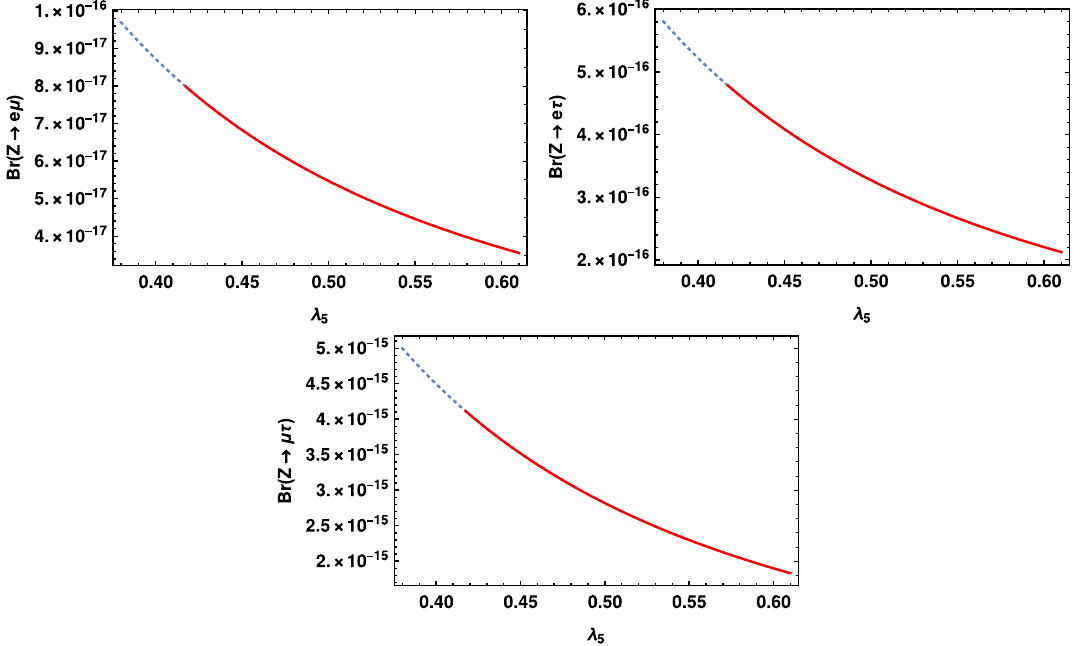
Fig. 4 Plots between Br ( Z → (cid:2) α (cid:2) β ) and λ 5 for the case of NO, after applying the constraints from Br ((cid:2) α → (cid:2) β γ) . In these plots, solid lines are allowed and dotted lines are excluded by the constraints due to Br ((cid:2) α → (cid:2) β γ) . Numerical values for neutrino masses are taken from